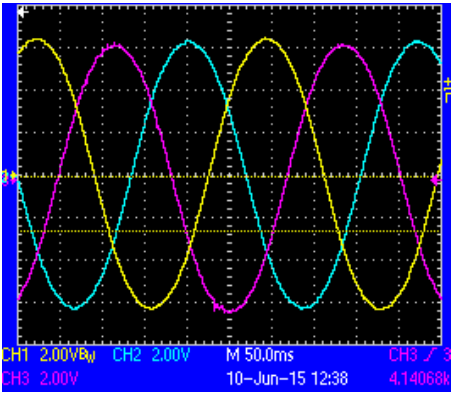
Figure 12. The measured no ‐ load back ‐ EMF waveform.